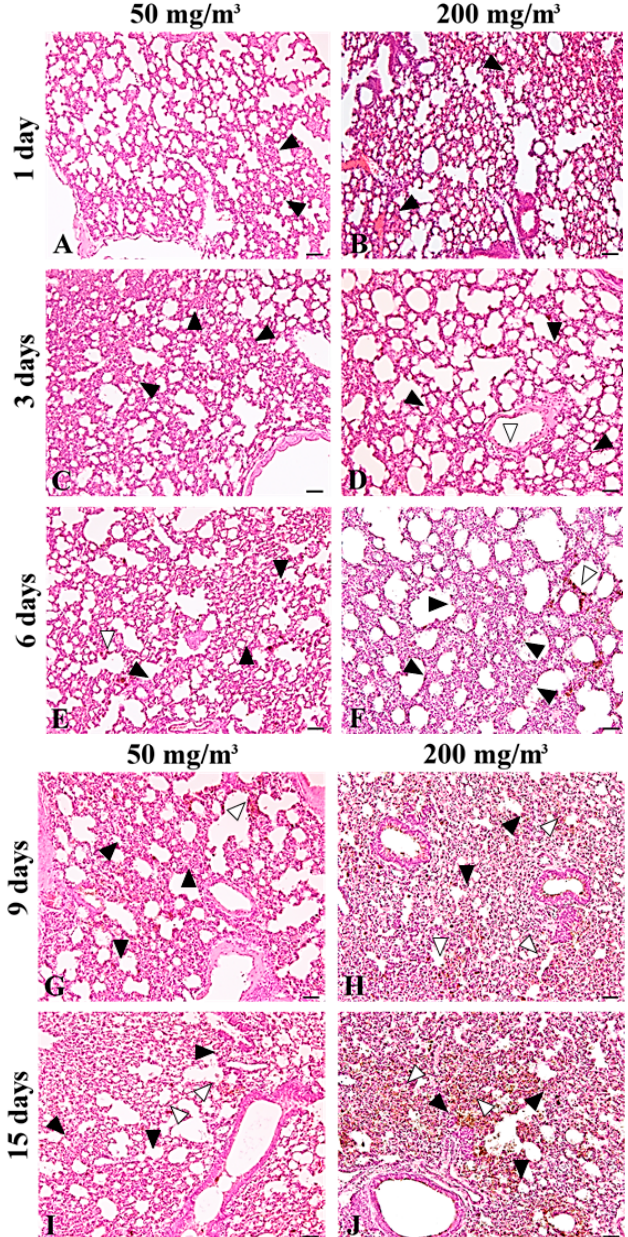
Figure 2. Histological examination of the lung taken from mice treated with Kanto loam powder showed acute inflammatory changes. Representative lung sections taken from mice treated with 50 mg/m 3 of the powder at one day ( A ); three days ( C ); six days ( E ); nine days ( G ); and 15 days ( I ) after exposure, and from mice treated with 200 mg/m 3 Kanto loam powder at one day ( B ); three days ( D ); six days ( F ); nine days ( H ); and 15 days ( J ) after exposure. Diffuse deposition of the particles (white arrowheads) at the bronchial mucosa and alveolar wall, and infiltration of inflammatory cells (neutrophils and macrophages) (black arrowheads) in the alveolar wall and alveolar space are observed; these changes become prominent with both time and concentration of the particles. HE. Bars = 50 µm.